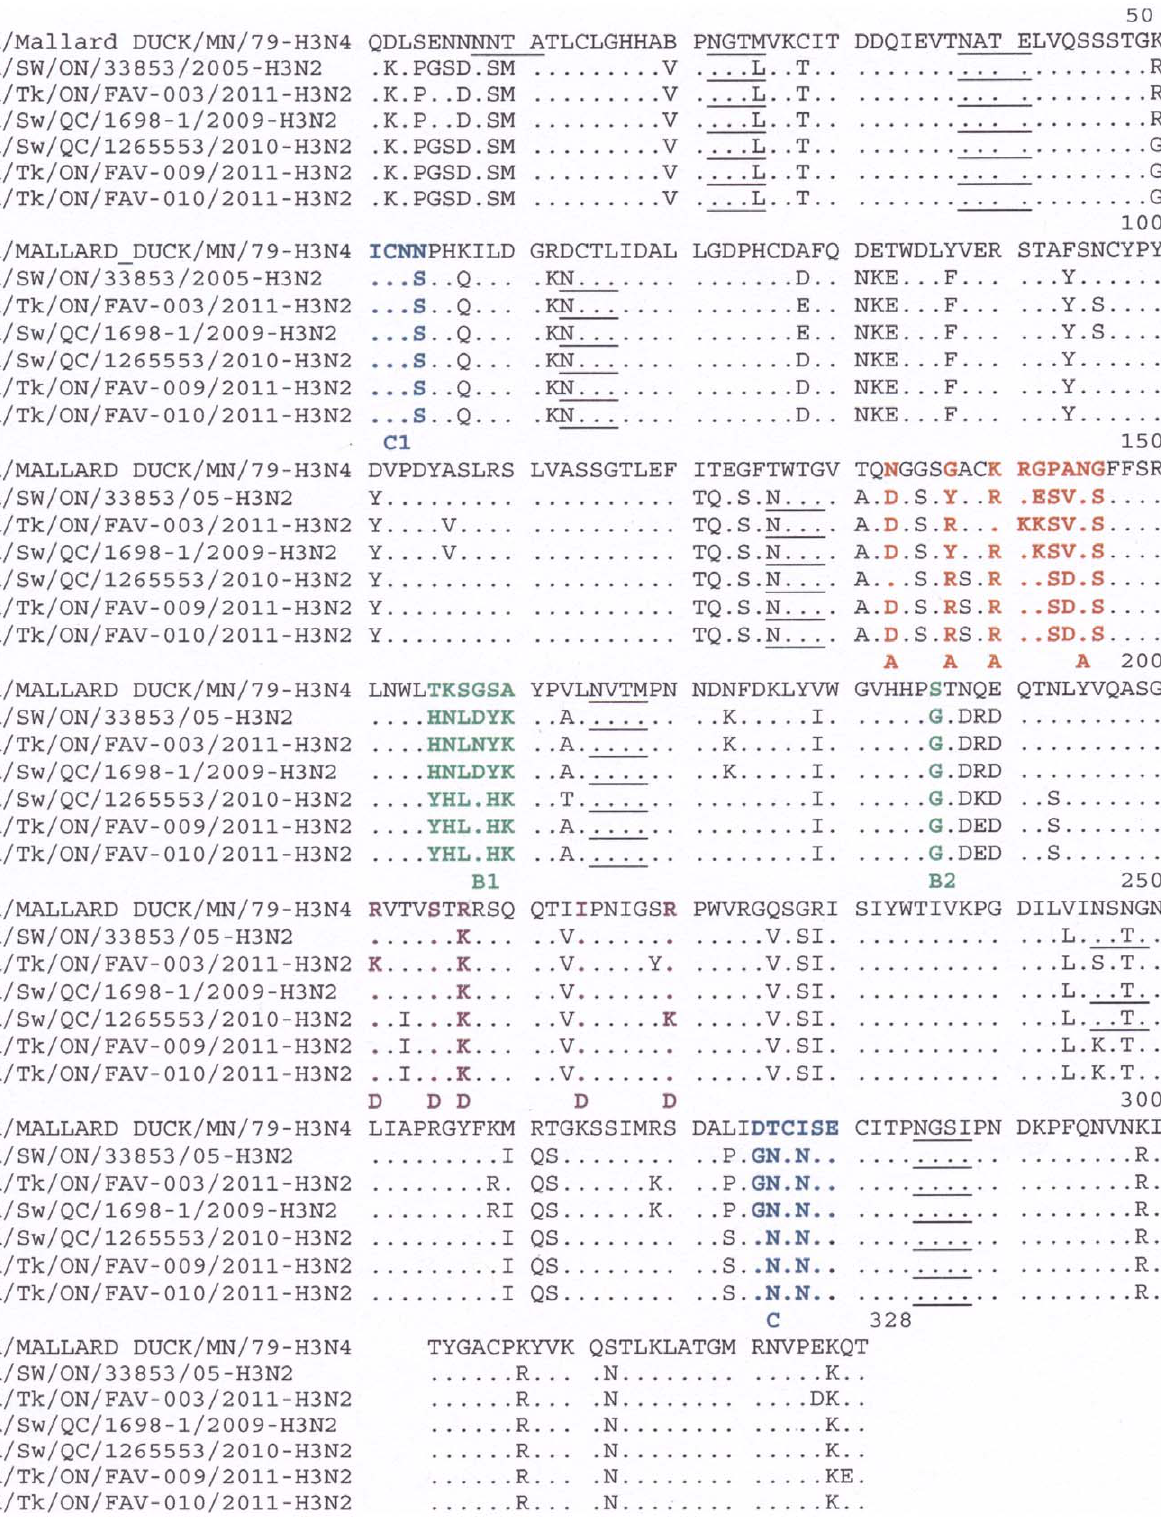
Figure 3. Alignment of the H3 HA1 amino acid sequences (without signal peptide). Amino acids of the HA1 subunit of the three unique turkey isolates, the duck H3N4 vaccine strain, a prototype cluster IV TR H3N2 virus (A/SW/ON/33853/2005) and phylogenetically related isolates A/Sw/ QC/1265553/2010 (H3N2) and A/SW/QC/1698-1/2009 (H3N2) were aligned. Residues shown in red, green, blue and purple represent previously identified antigenic sites A, B, C and D respectively. Potential glycosylation sites are underlined.